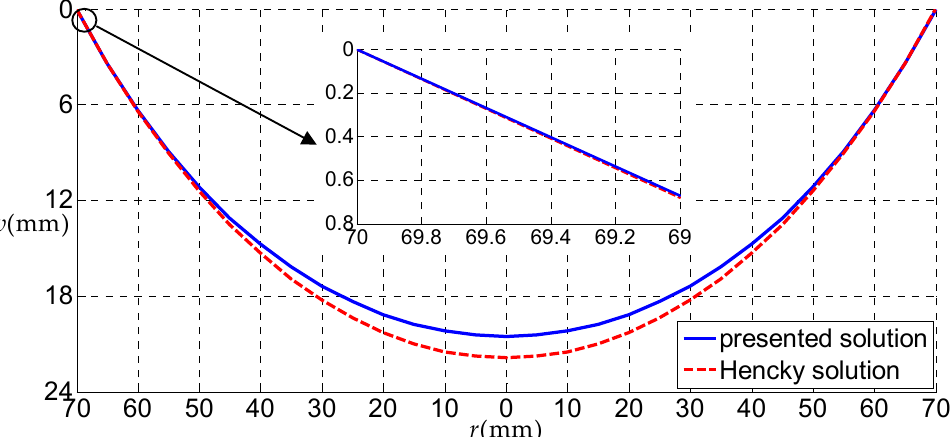
Figure 8. The variations of w with r when q = 0.07 MPa.